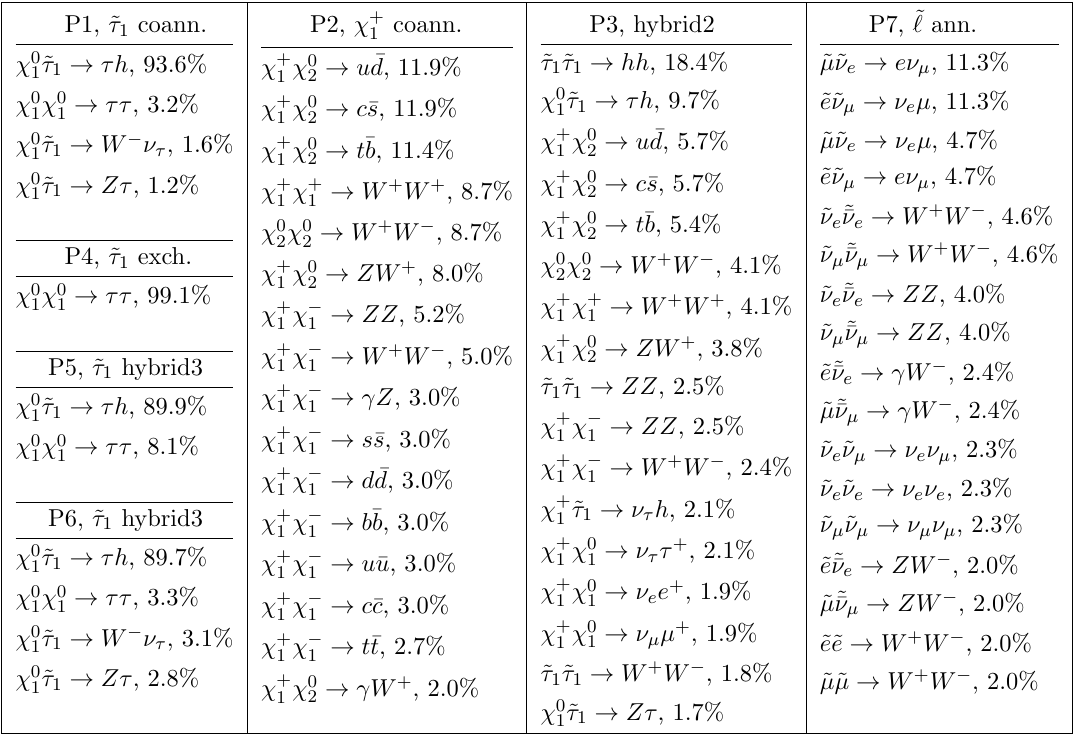
Table 2 . The main annihilation channels and their relative contributions to h (cid:27)v i for the 7 bench- mark